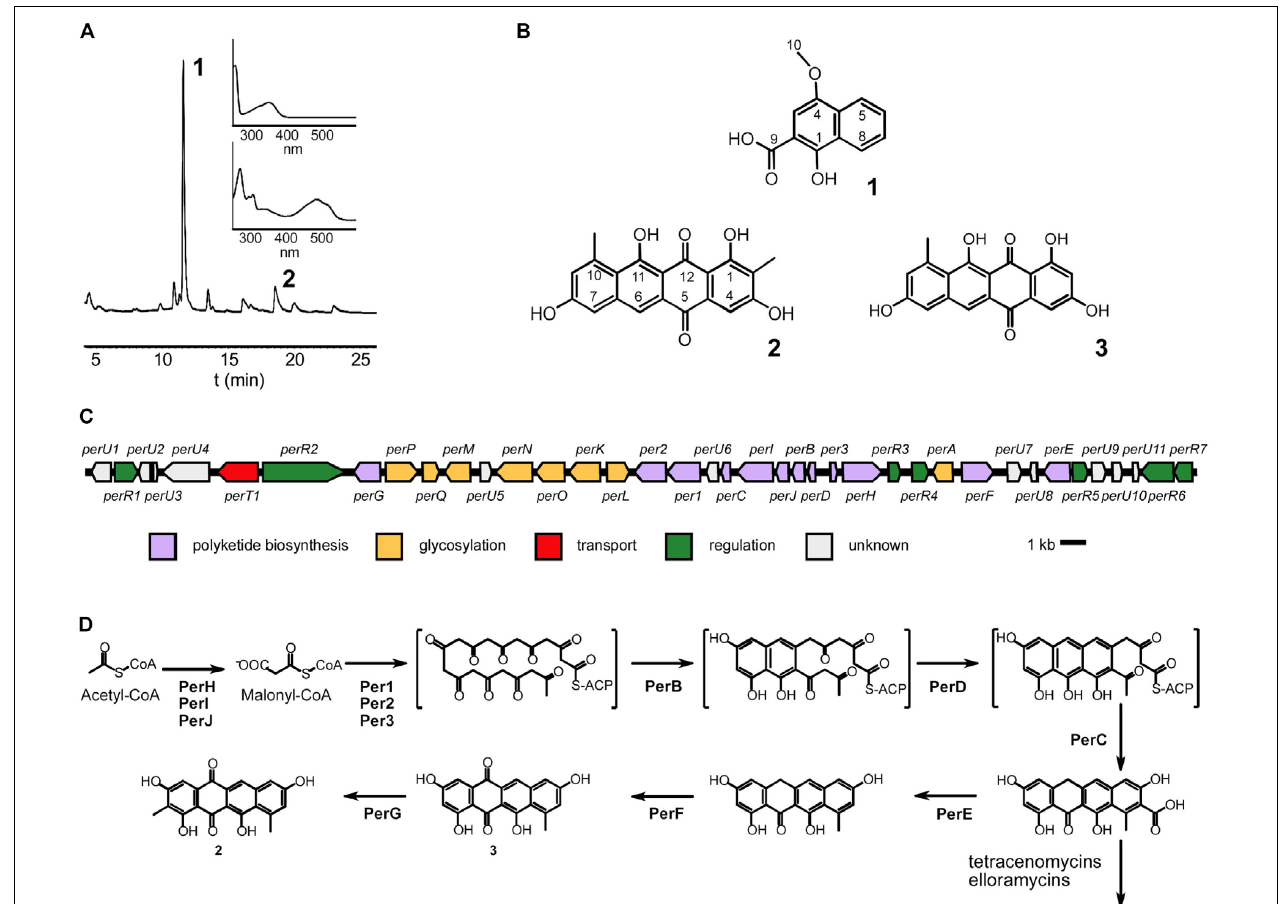
FIGURE 5 | Characterization of Streptomonospora sp. PA3 metabolites and biosynthesis of persiamycin A. (A) HPLC trace of a methanol extract shown at 256 nm and the UV/VIS spectra of the purified compounds 1-hydroxy-4-methoxy-2-naphthoic acid (1) and persiamycin A (2) . (B) Chemical structures of (1) , (2) and the related compound tetracenomycin D (3) . (C) Graphical representation of the persiamycin gene cluster and (D) model for the biosynthesis of 2 . The biosynthetic pathways of persiamycins and tetracenomycin/elloramycins appear to have diverged after fourth ring cyclization.